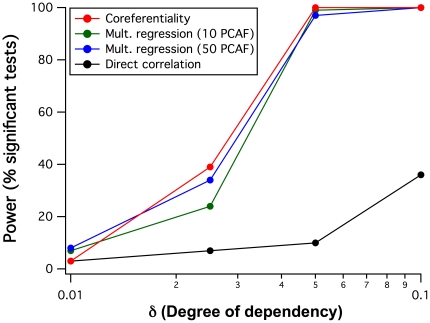
Comparison of the statistical power to detect coreferentiality, dependency in multiple regression, and classic correlation.The power of each method was tested in 100 respectively simulated data sets, all with a sample size of 200 and different reference data dependency degrees δ. Multiple regression was tested for a given test variable X in dependency on the scores of either 10 or 50 PCA factors derived from the 130 reference variables. Bivariate correlation was tested for simulations with X2 depending on X1 with the degree δ, and tested by simple linear regression.